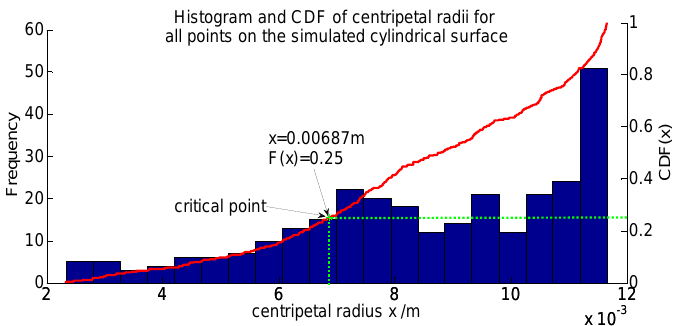
Figure 7. Histogram and cumulative distribution function (CDF) of centripetal radii for all points on the simulated cylindrical surface. (The cylinder is simulated based on the actual experiment condition in Section 4.)